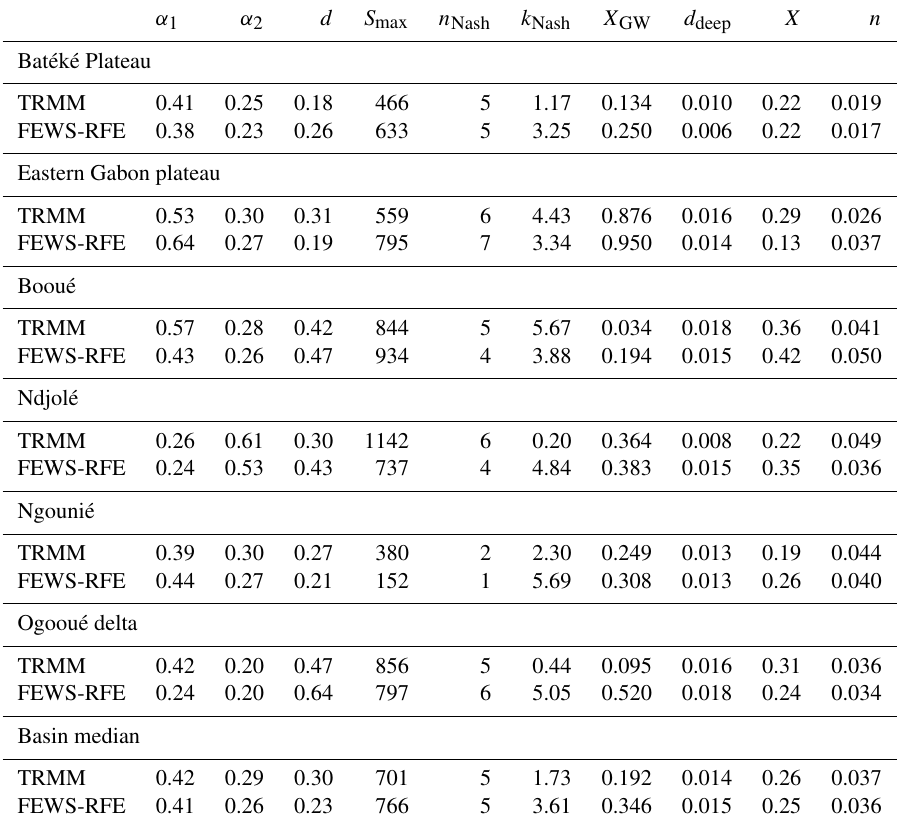
Table 3. Calibrated parameters from the two models forced by TRMM and FEWS-RFE precipitation. α 1 α 2 d S